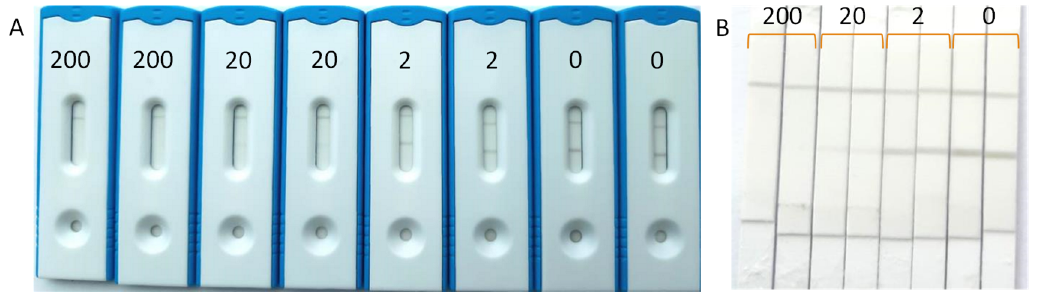
Figure 4. Surface water from a brook (Wageningen, The Netherlands) fortified with CHLP at 200, 20, 2, and 0 µg/L and applied to the LFIAs in duplicate. Visual imaging was performed in the assembled cassettes ( A ) and with strips removed from the cassettes for digital imaging ( B ).